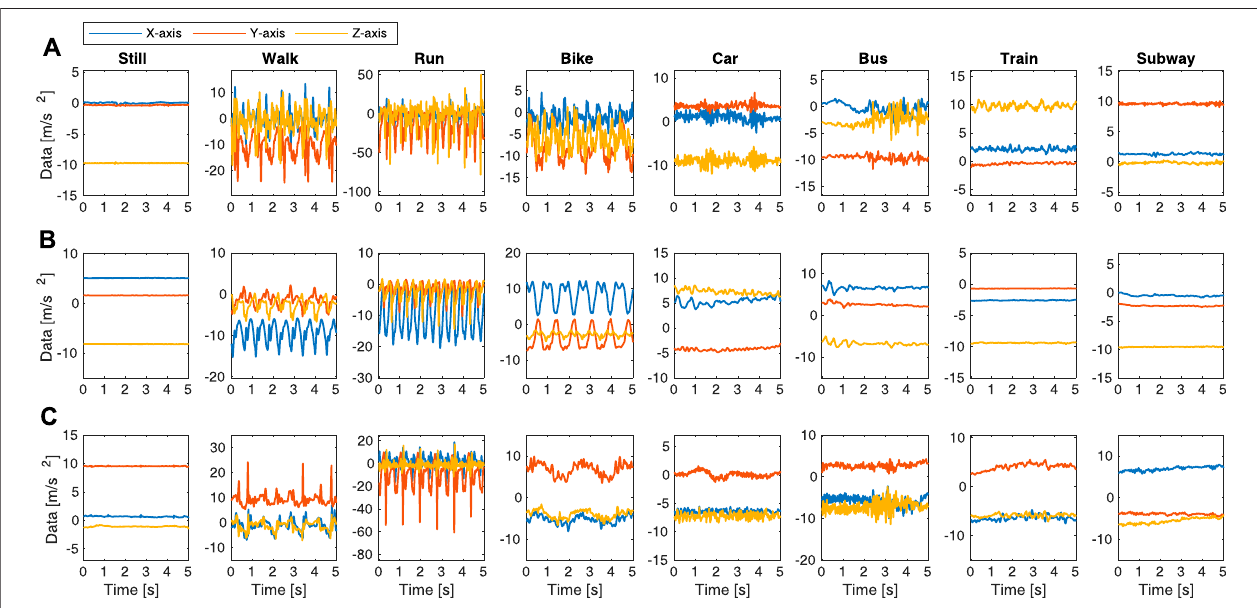
FIGURE 8 | Exemplary samples of accelerometer data in SHL 2020. The data is collected by three users at Hips position: (A) User1; (B) User2; (C) User3.